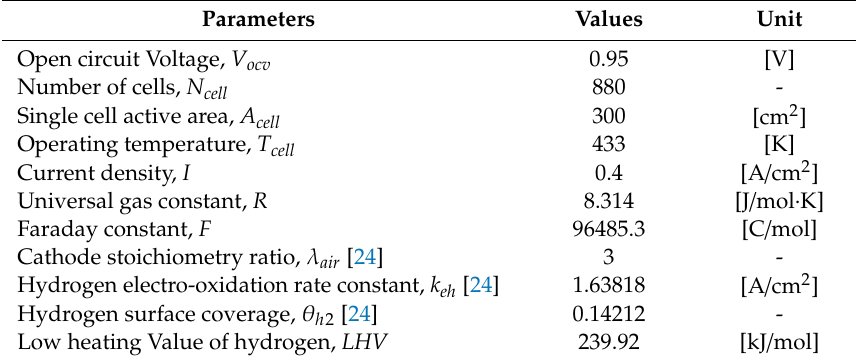
Table 2. Operating parameters and empirical parameters used in the HT-PEMFC model.